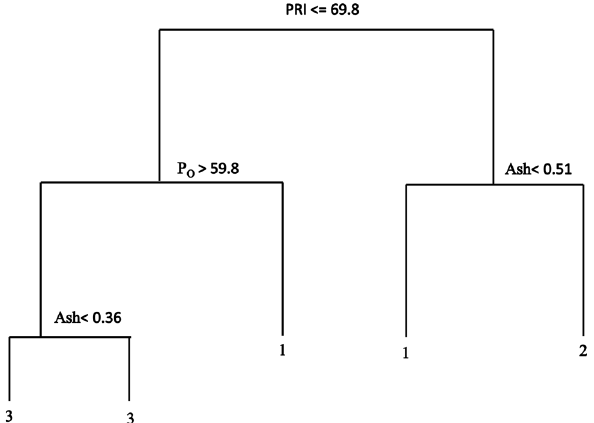
Figure 5. Decision trees for the natural rubber compounds of rubber tree. The root of the tree is divided into two nodes according to PRI < 69.8% (left branch) and PRI ≥ 69.8% (right branch). The right branch is divided according to Ash, yielding Node 3 [Ash < 0.51% (cluster 1)] and Node 4 [ASH > 0.51% (cluster 2)]. The left branch is divided according to Po [Node 5 Po < 0.36 and Node 6 Po ≥ 0.36]. The classification used only